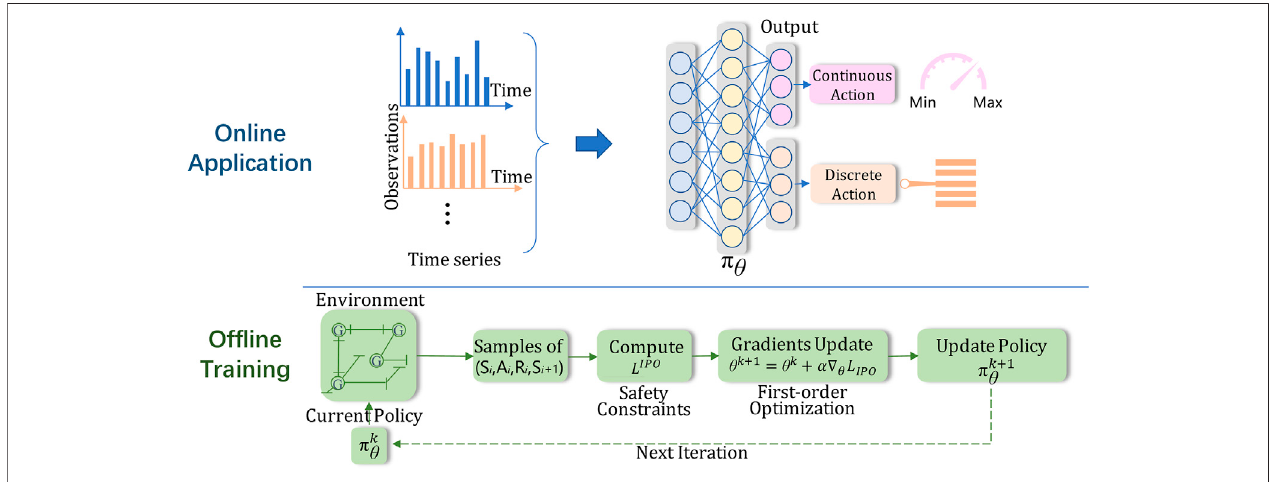
FIGURE 1 | Framework of the proposed